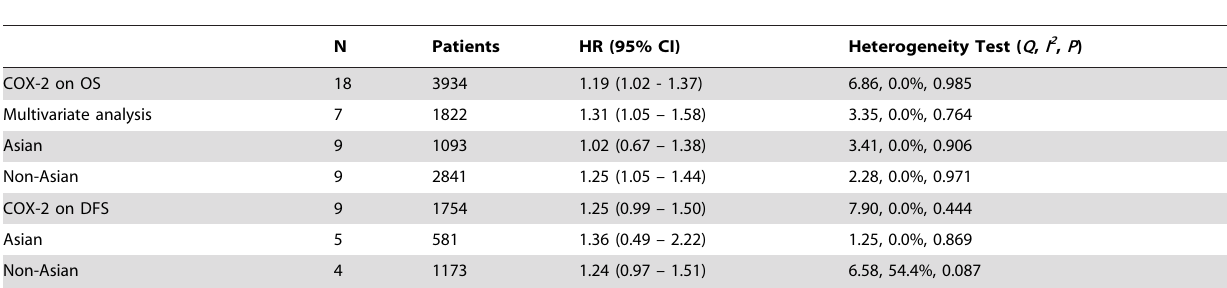
Table 3. Meta-analysis. HR value in subgroup analysis according to outcomes of interest, and